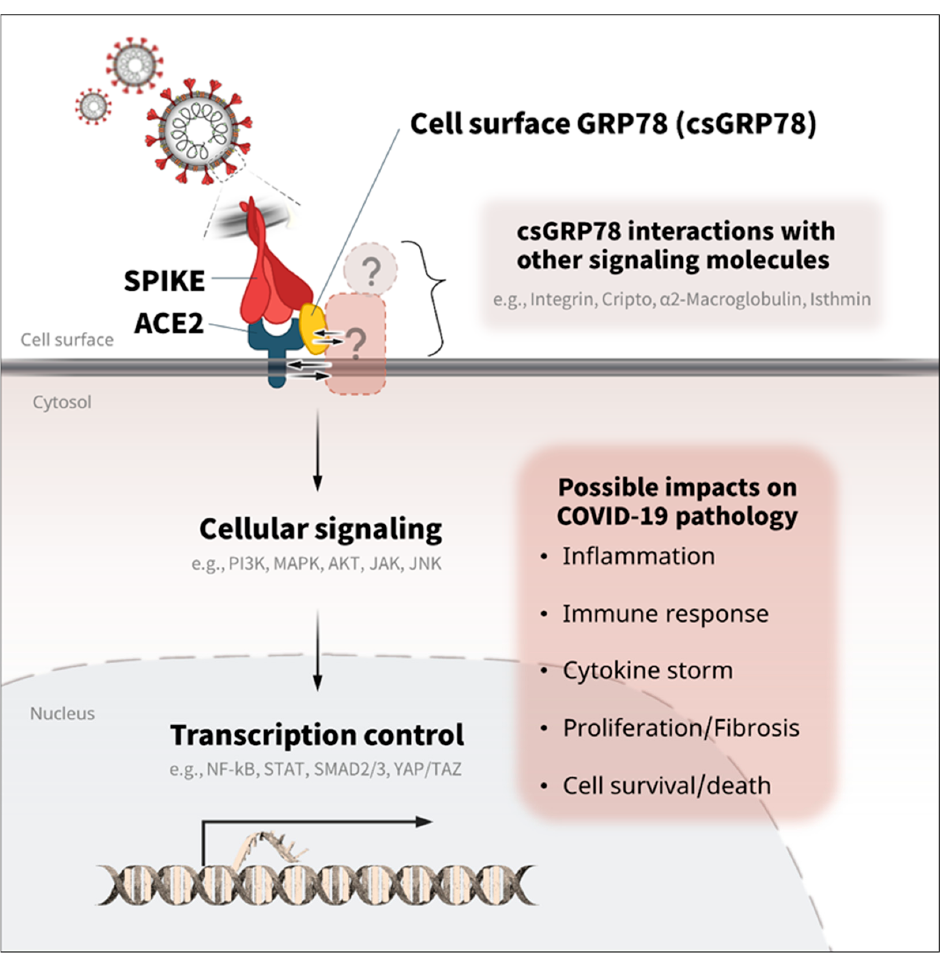
Figure 3. Potential roles of GRP78 in the cellular signaling and transcription of COVID-19. GRP78 is associated with various cellular signaling and transcription activities involved in inflammation, cytokine release, fibrosis, and cell survival/death [13,51–55]. Thus, the direct and/or indirect